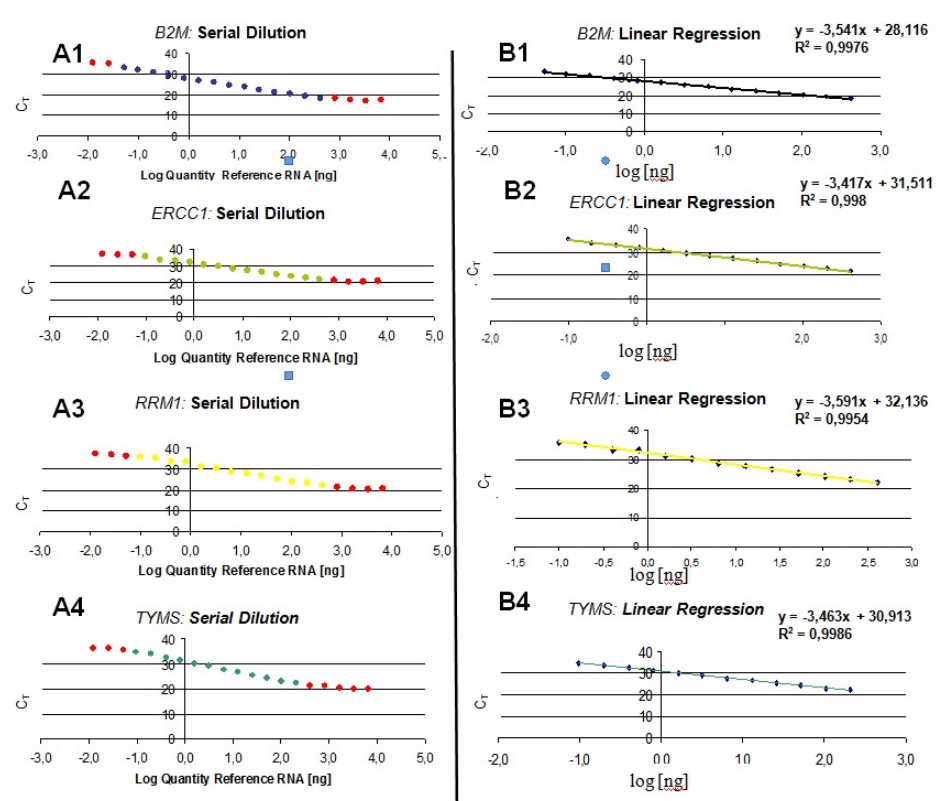
Figure 8. ( A1-4 ) Standard curve derived from serial dilutions of Reference RNAs (Stratagene) for different assays. ( B1-4 ) The equation of the linear regression was determined for each assay of B2M , ERCC1 , RRM1 and TYMS